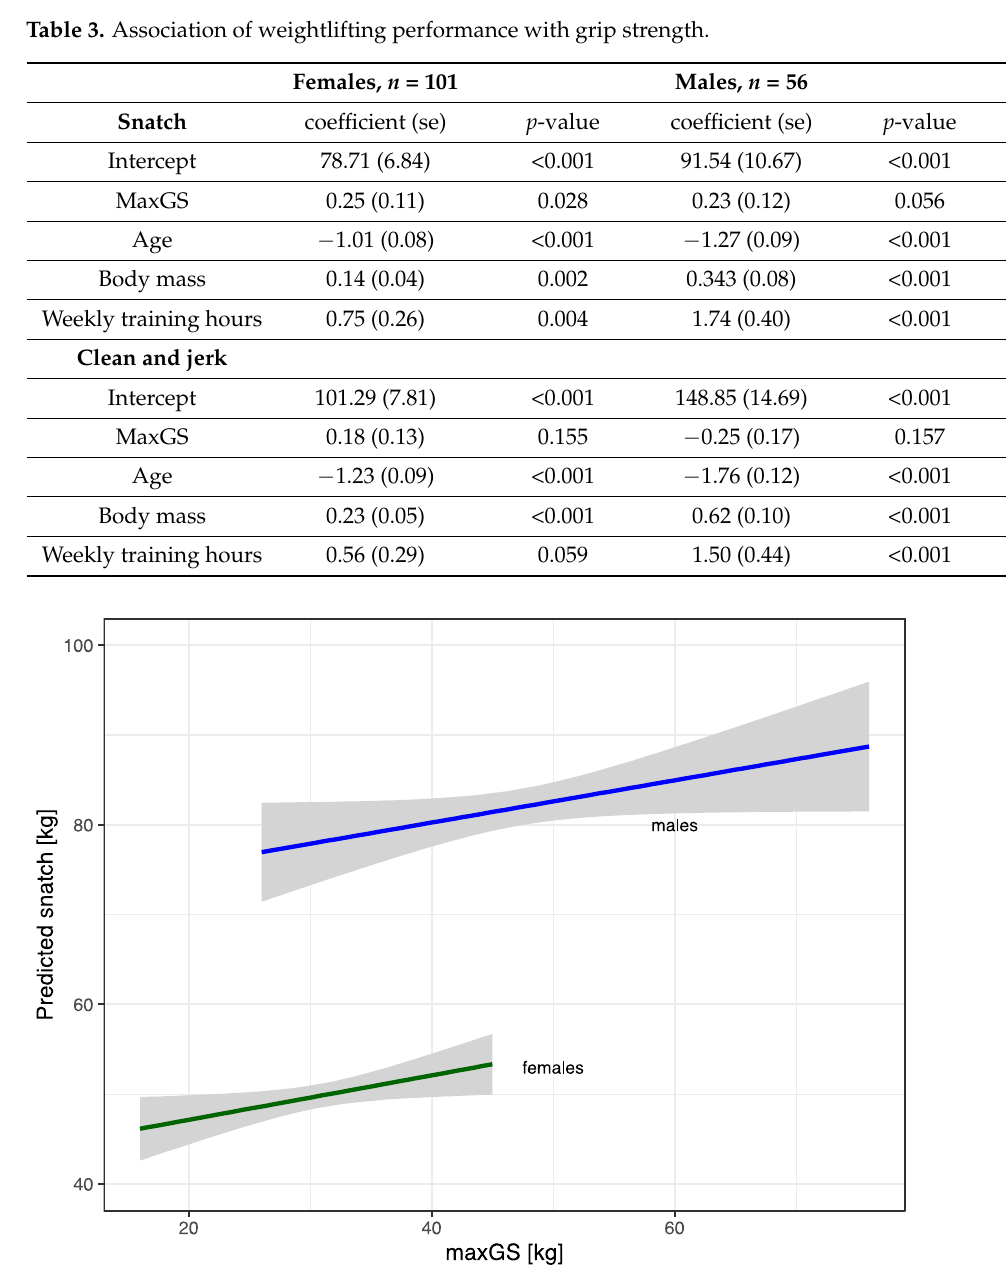
Figure 3. Predicted snatch performance from maxGS with 95% confidence intervals. The GS ratio was statistically significant different from 1.0, with a skewed distribution toward the dominant hand ( p < 0.001 for males and for females) (Figure 4). The mean difference between the maxGS of the dominant and non ‐ dominant hands was 1.8 kg. Females had more asymmetry than males (t= − 2.29, p = 0.023). Hand asymmetry occurred in 30.9% (95% confidence interval: 23.9%, 38.0%) of the weightlifters with a GS ratio larger than 1.1 or smaller than 0.9. There were no chronic medical conditions or prior hand/wrist injuries that could explain the asymmetry for weightlifters falling outside the confidence limits in the Bland–Altman plot (Figure 5). However, two of the eight athletes did not total in the competition, while 7.1% of all competitors did not total. “Not total” means they missed all three lifts of the snatch or of the clean and jerk. Two men had clinically relevant weak GS, defined as less than 26 kg for men and less than 16 kg for women [26]. They were older than 70 years, and one did not total.